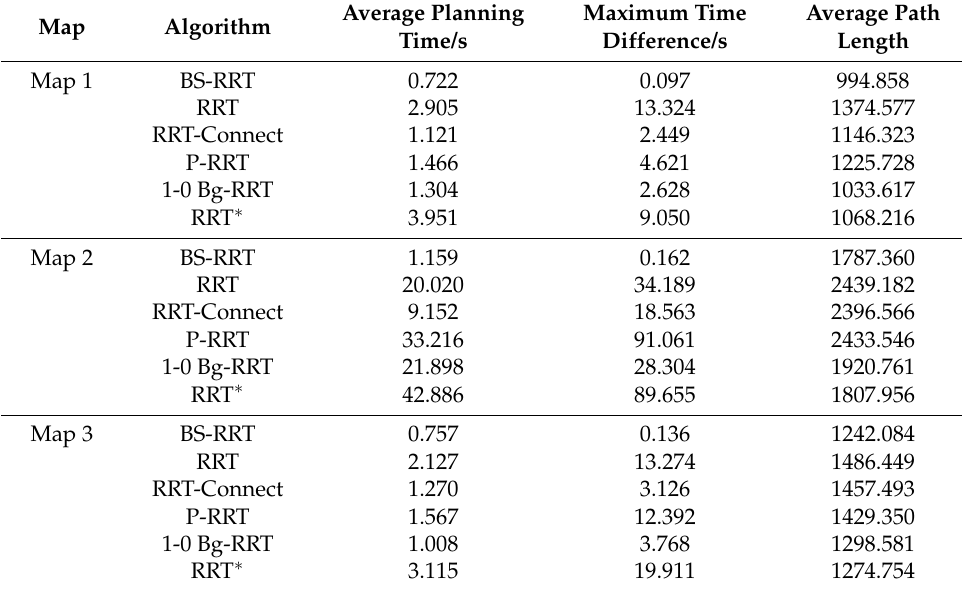
Table 3. Time data from 50 experiments for the six algorithms.